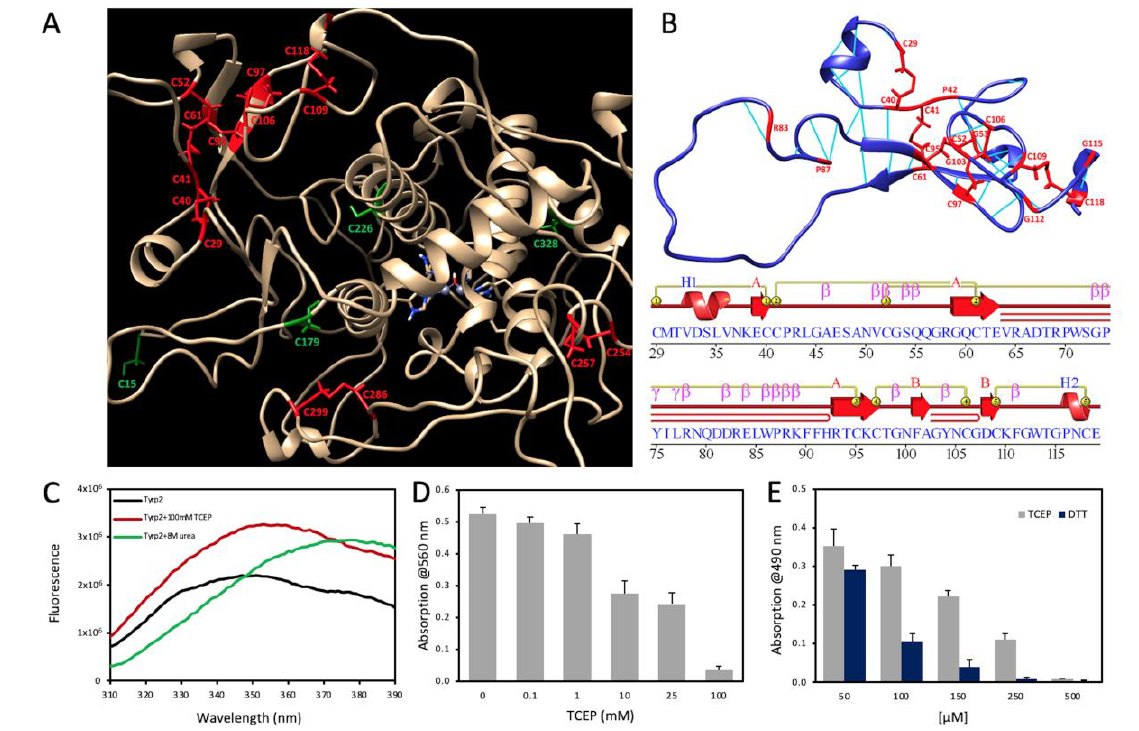
Figure 4. Influence of reducing agents on Tyrp2 stability and dopachrome tautomerase activity. ( A ) Cys residues of Tyrp2 mapped to the human 100 ns Tyrp2 structure (gold ribbon) modeled as described in the Materials and Method section. Cysteines involved in disulfide bridges are red, and the intact Cys residues are green. ( B ) Homology model (top panel) and topology (bottom panel) of the Cys-rich domain of Tyrp2. The homology model is colored accordingly to the residue foldabilities. Residues with foldability 19 are critical for domain stability (red). In the bottom panel, elements of the secondary structure are in red. Disulfide bridges are yellow lines. ( C ) Intrinsic tryptophan fluorescence spectra of the native Tyrp2 are shown by the black line. Tyrp2 spectra are shown after the incubation for 1 h in 100 mM TCEP (red line) and 8 M urea (green line). Emission of 5 μM protein samples excited at 280 nm registered between 300 and 400 nm. ( D ) Dopachrome tautomerase activity of Tyrp2 decreases with the increase of the reducing agent (TCEP). Activity measured spectrophotometrically (absorption at 560 nm) in 50 mM Tris buffer, pH 7.4, after 1 h of incubation at 37 °C in the presence of TCEP in the range of 0 – 100 mM. Tyrp2 concentration was 0.25 mg/mL. ( E ) Inhibitory effect of TCEP (grey bars) and DTT (dark blue bars) reducing agents on diphenol oxidase activity of Tyr. Activities were measured spectrophotometrically (absorption at 490 nm) in 50 mM sodium phosphate buffer, pH 7.5, after 30 min of incubation with reducers (0 – 500 mM) at 37 °C. Tyr concentration was 0.5 mg/mL.